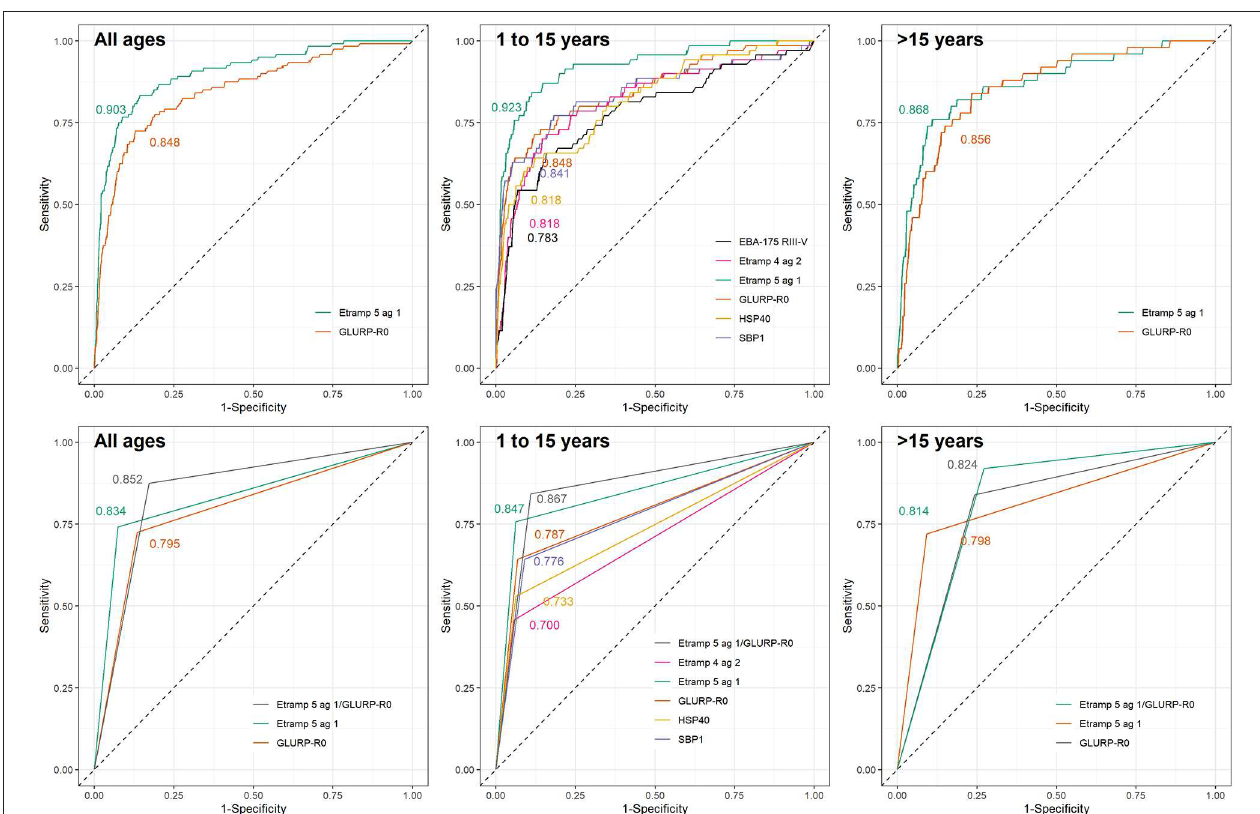
FIGURE 3 | Receiver operating characteristic curves for immunoglobulin G (IgG) responses to selected Plasmodium falciparum antigens using highly sensitive rapid diagnostic test (hsRDT) status as the gold standard. IgG responses in one-thirds of all EAG-Grand’Anse participants were used (i.e., the test dataset; n = 1,648) including 120 hsRDT positives (7.3%). IgG responses were defined as log10-transformed median fluorescence intensities corrected for background reactivity. Results are shown for continuous IgG responses (top) for antigens with an area-under-the-curve (AUC) > 0.8 in the training dataset ( Figure 2 ). Seropositivity results (bottom) are only shown for antigens with an AUC > 0.8 using continuous IgG responses in the test dataset (top). AUC values are depicted on each plot. From left to right results are shown for: all ages, children aged 1 to 15 years and individuals older than 15